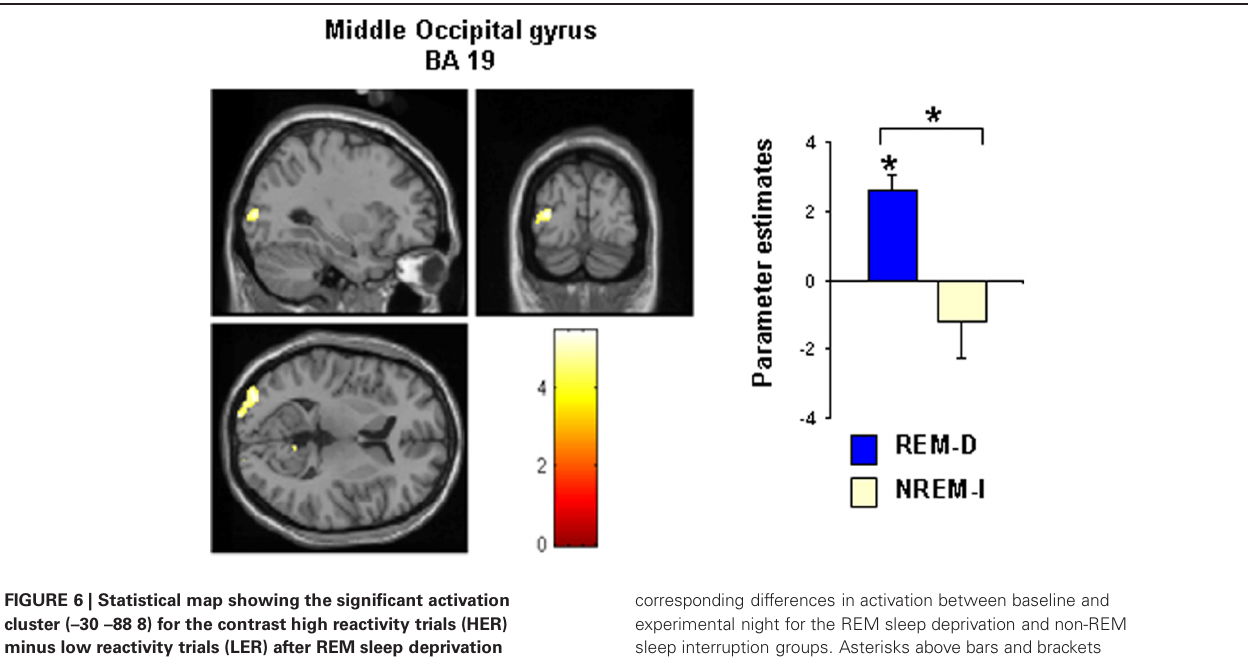
Table 3 for all significant activations. Bar graphs show the